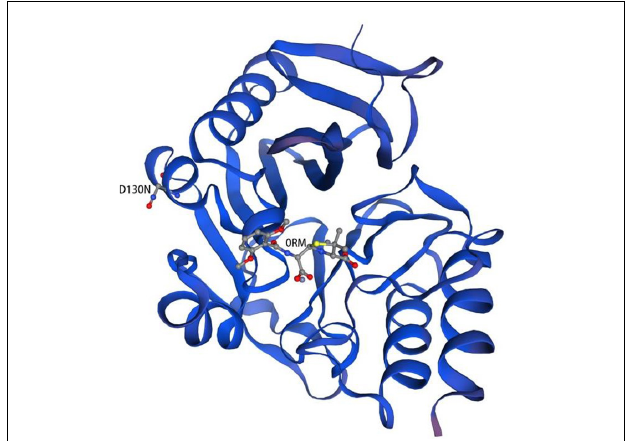
will be discussed in detail in subsequent sections, Table 2